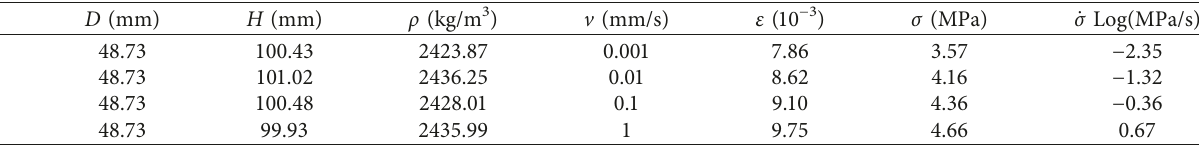
Table 1: Test parameters for the direct tensile test specimens.